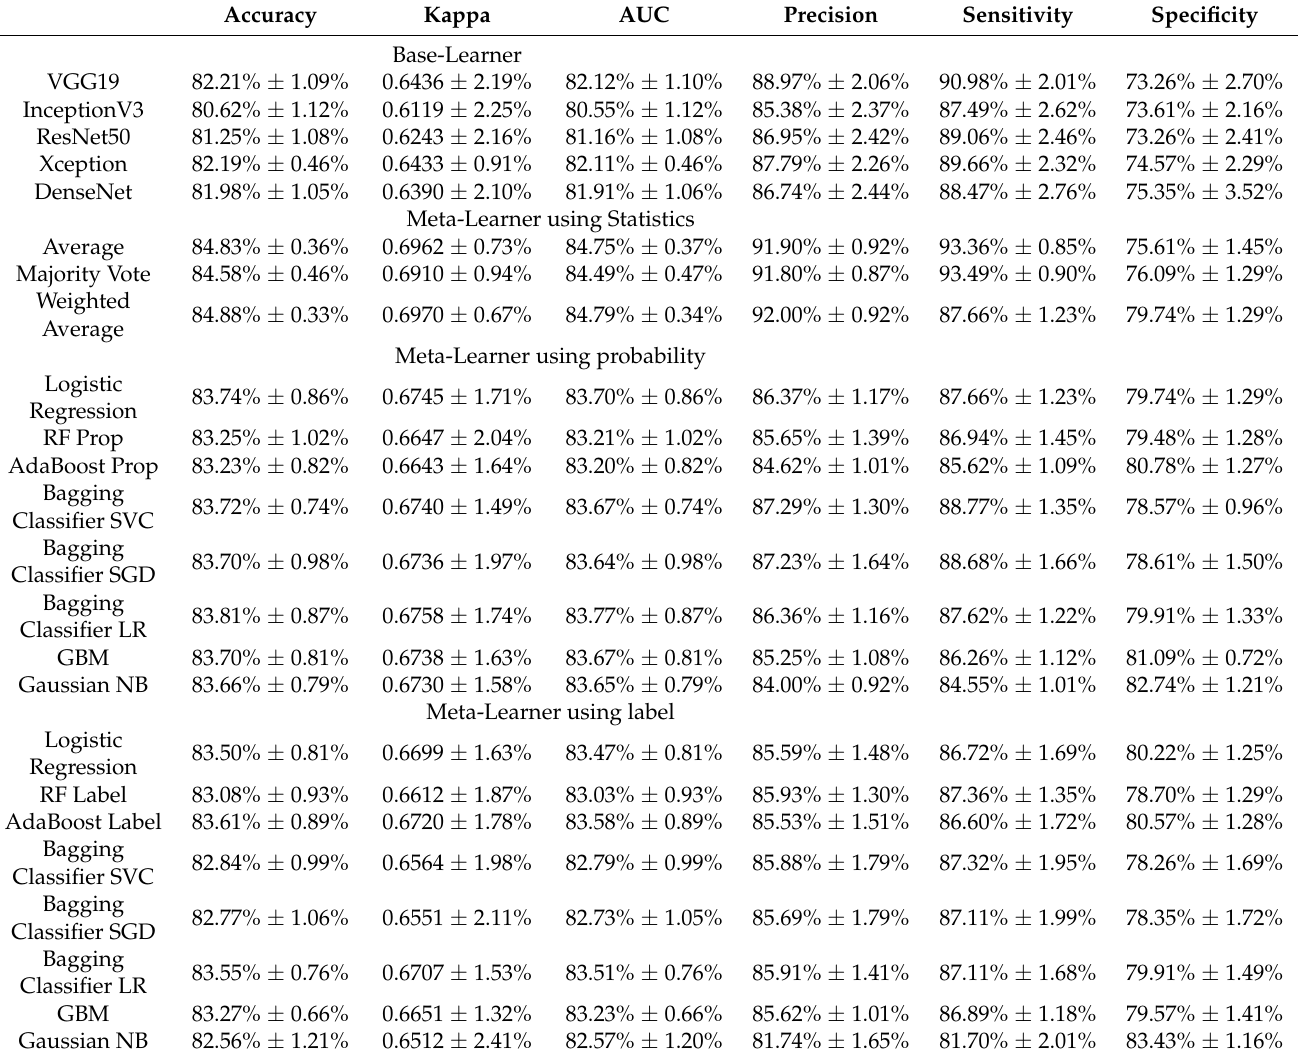
Table A3. The Kappa score achieved by each classifier for the elbow images ( ± Confidence Interval 95%). Test performance is